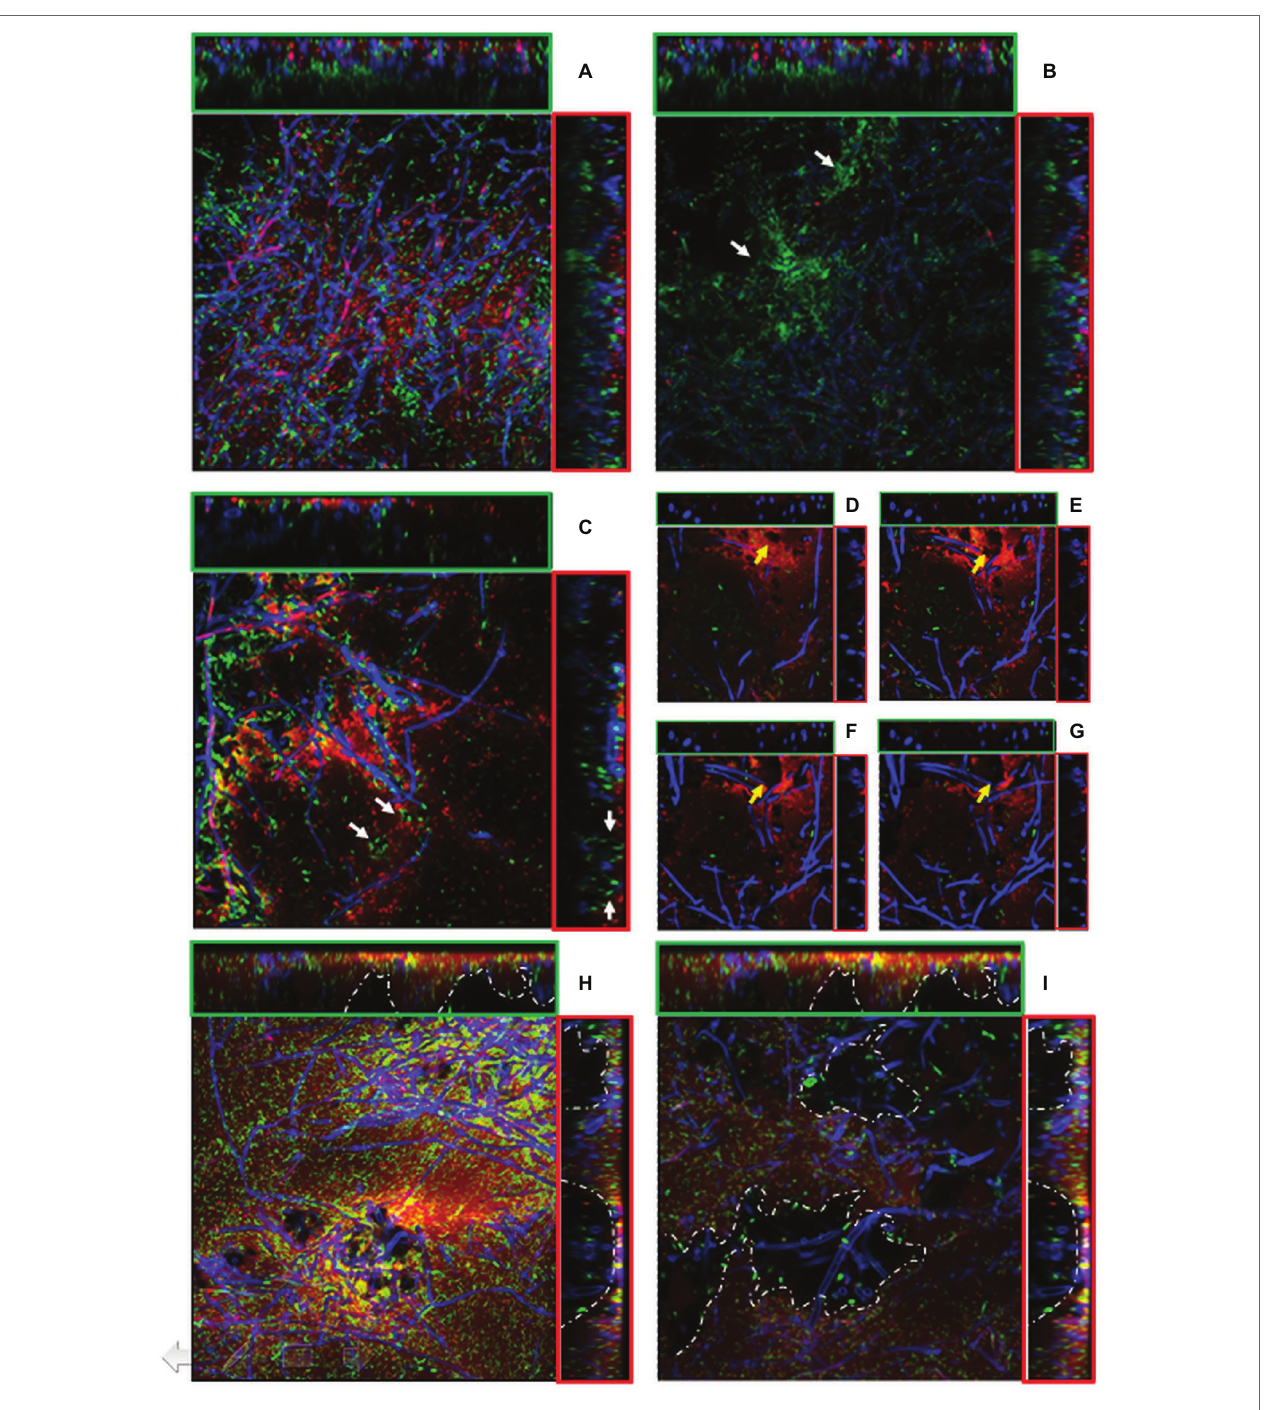
FIGURE 5 | (A–I) . CLSM images of mixed P. ostreatus-P. alcaliphila biofilm after 24 h (A,B) , 48 h (C–G) , and 72 h (H–I) from bacterial inoculum application after concomitant Syto 9 (green fluorescence) and Propidium iodide (red fluorescence) stain followed by Calcofluor staining. Orthogonal y-z and x-z views are delimited by green and red frames, respectively. Each image represents an area of 45.17 × 10 3 μm 2 (magnification 40×) and 18.21 × 10 3 μm 2 (magnification 63×). (A) sub-population of non-clustered viable bacterial cells in 24-h-old mixed biofilm (x-y view) with initial ECM deposition in the outer layer (x-z and y-z orthogonal views); (B) viable bacterial cluster in close proximity of inner voids (x-y view, white arrows) in 24-h-old mixed biofilm; (C) localization of viable bacterial cells at the edges of voids in 48-h-old mixed biofilm (x-y view, white arrows) (40× magnification);. (D–G) , Increase in the lumina of void channels in 48-h-old biofilms from a depth of 1.03–4.24 μm (x-y view, yellow arrows) (63× magnification); (H) 72-h-old mixed biofilm characterized by a compact structure with interspersed void channels indicated by white arrows (depth: 6.43 μm, magnification: 40×); (I) the edges of large cavities are delimited by a dotted white line in 72-h-old biofilms (depth: 23.54 μm, magnification: